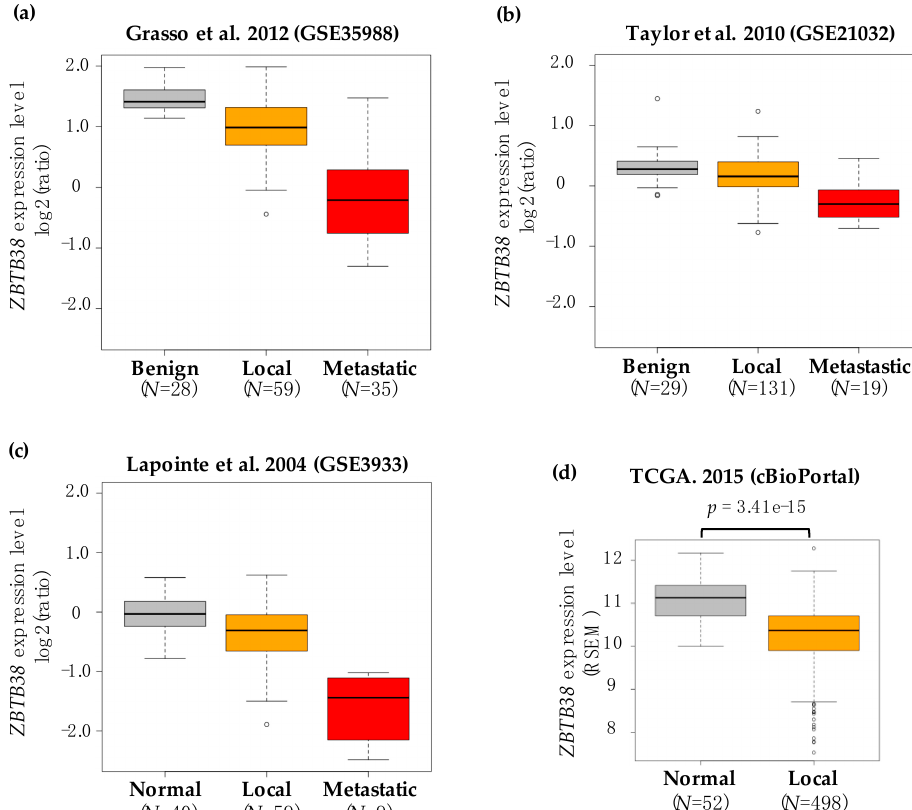
Figure 1. ZBTB38 expression is lower in prostate cancer compare to non-cancerous tissues. ( a–c ) Box plot showing the levels of ZBTB38 mRNA expression in benign / normal tissues (in grey), localised tumours (in orange) and metastatic tumours (in red) in three independent prostate cancer cohorts. ZBTB38 transcript is reported as log2 median-centered ratio. ( d ) Box plot showing the levels of ZBTB38 mRNA expression in normal tissues (in grey) and localised tumours (in orange) from the TCGA cohorts. ZBTB38 transcript abundance is quantified using RSEM tool (see Materials and Methods). N : number of patients per class.